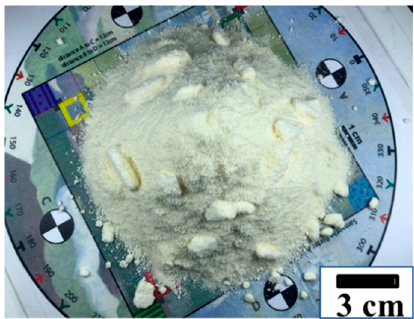
Figure 3. An example picture of a cone.